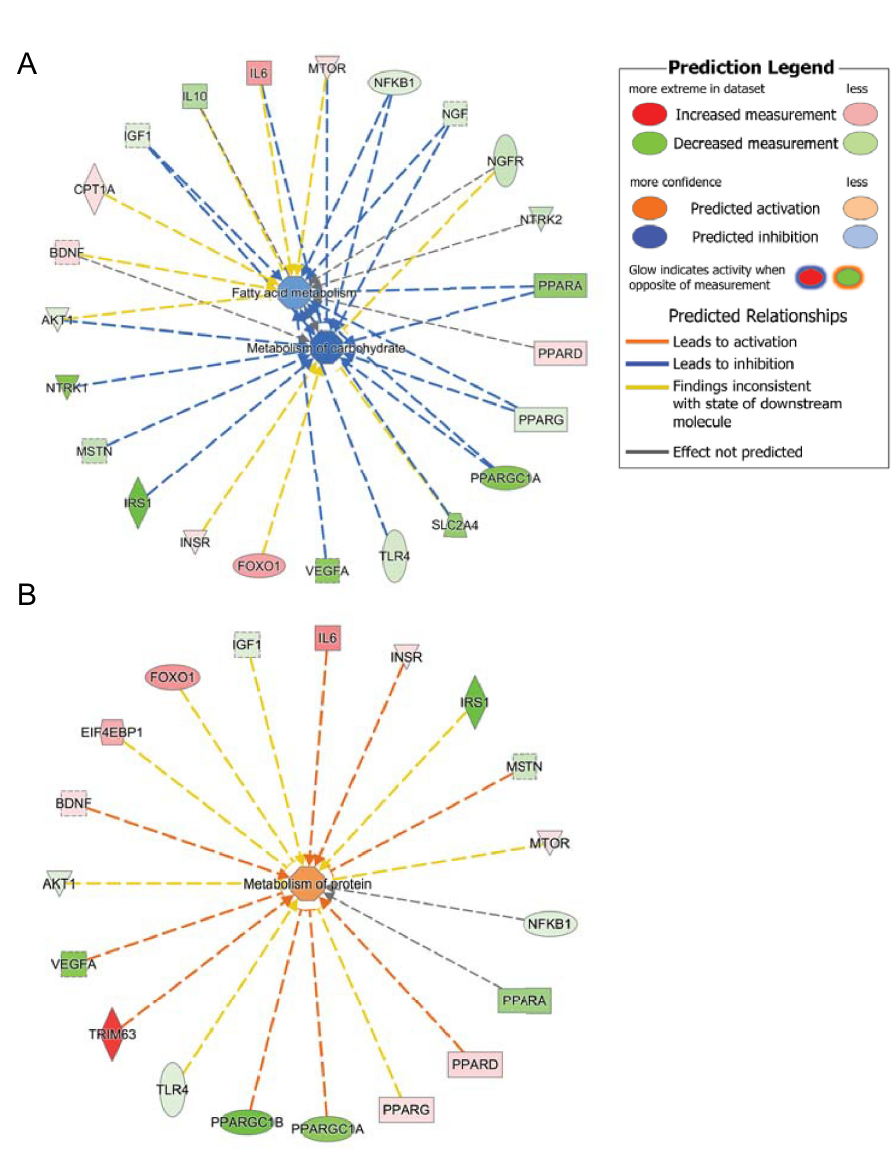
Fig 5. Schematic of the prediction of metabolic events in muscle of CIA rats by Ingenuity Pathway Analysis. The outer ring reflects the most differentially regulated mRNAs in CIA rats compared to control rats and with the colour intensity associated with a p-value and reflecting greater (red) or less (green) expression relative to control. The centre of each ring reflects Ingenuity Pathway Analysis prediction of inhibition of carbohydrate and fatty acid metabolism (A) and activation of protein metabolism (B) in the CIA group based on the collective mRNA expression changes from